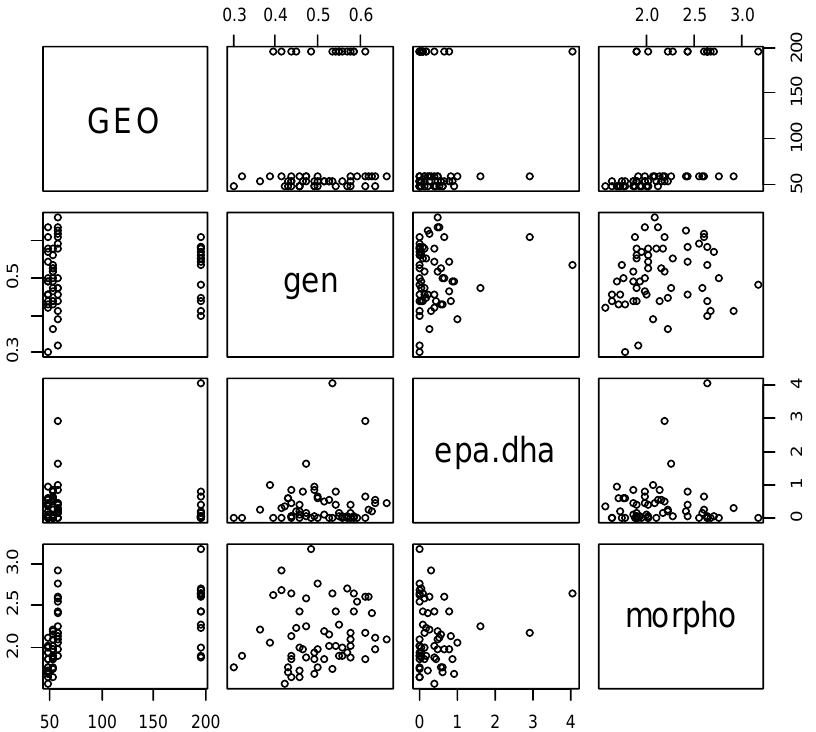
Figure 9. Correlations between the different matrices (geo: geographic matrix; gen: genetic matrix; epa.dha: EPA and DHA content in leaves matrix; morpho: morphological matrix).